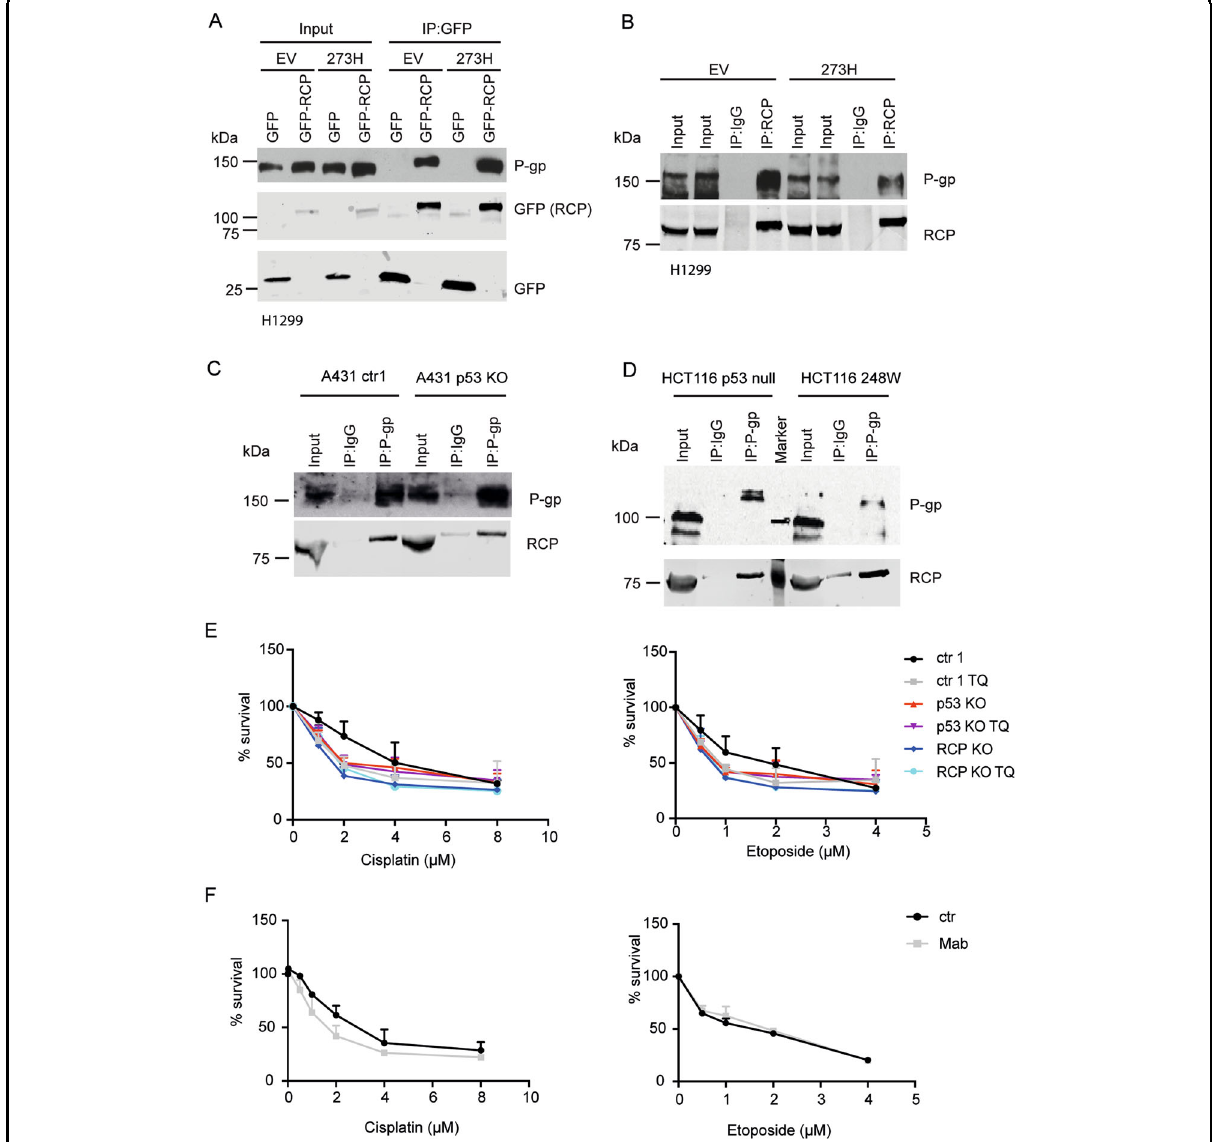
Fig. 3 RCP interacts with P-gp. A H1299 cells, stably expressing mutant p53 R273H or an empty vector (EV) (PCB6) were transfected with GFP or GFP-RCP and cell lysates were immunoprecipitated with GFP. P-gp and GFP expression was analysed by western blot. B Cell lysates of H1299 cells stably expressing mutant p53 R273H or an EV (PCB6) were immunoprecipitated with RCP or an IgG control. P-gp and RCP expression was analysed by western blot. C P-gp and IgG were immunoprecipitated from A431 ctr or A431 KO cells. Endogenous P-gp and RCP protein levels were analysed by western blot. D P-gp and IgG were immunoprecipitated from HCT116 -/- or 248W cells. Endogenous P-gp and RCP protein levels were analysed by western blot. E Resazurin survival assay of ctr, p53 KO or RCP KO cells treated with increasing doses of cisplatin and etoposide in combination with 0.5 µM Tariquidar or DMSO control for 96 h. Statistical differences were measured using a paired two-way ANOVA corrected for multiple testing (two- sided) and IC50 values were measured using a linear regression analysis. IC50 and P -values can be found in Supplemental Tables 6 and 7. Error bars indicate SD of average values of three independent experiments. F Resazurin survival assay of ctr1 A431 cells treated with increasing doses of cisplatin or etoposide in the presence or absence of Mab16 (1 µg/mL) for 96 h. Statistical differences were measured using a paired two-way ANOVA (two-sided) corrected for multiple testing and IC50 values were measured using a linear regression analysis. IC50 and P -values can be found in Supplemental Table 8. Error bars indicate SD of average values of three independent